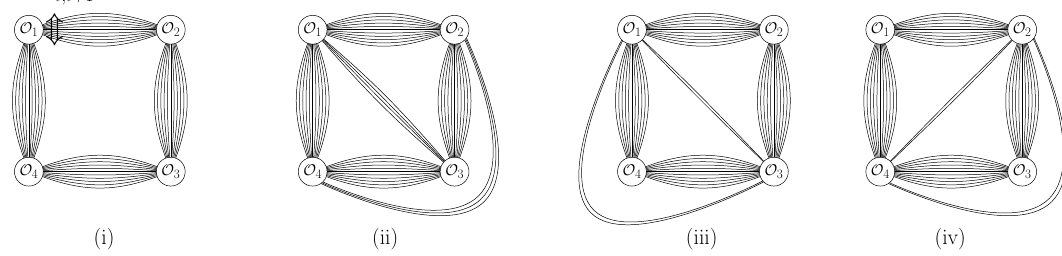
Figure 12 . The four types of skeleton graphs contributing to the large R-charge correlators or 10D null limit. All graphs have a square perimeter with bridges of infinite length and they are distinguished by the position and length of their diagonal